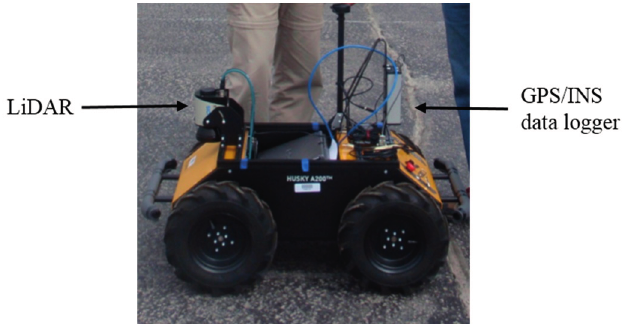
Figure 3. Experiment platform: Husky